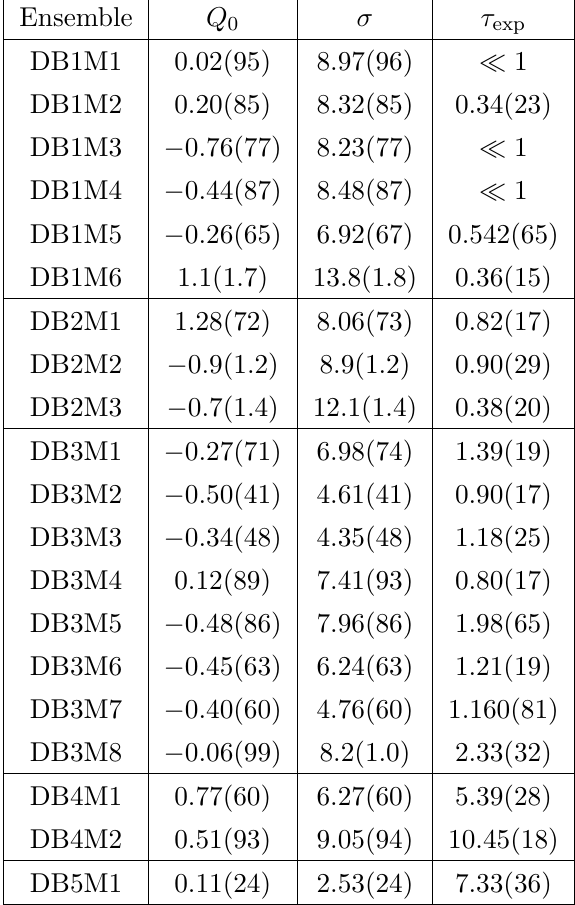
Table 3. Fit results of the topological charge to a Gaussian function for all ensembles. The quantities Q 0 and (cid:27) are de(cid:12)ned in eq. (3.10). They are the mean and the standard deviation for the distribution of the topological charge, respectively. In the last column, we present the results of the exponential autocorrelation time (cid:28) exp de(cid:12)ned in eq.